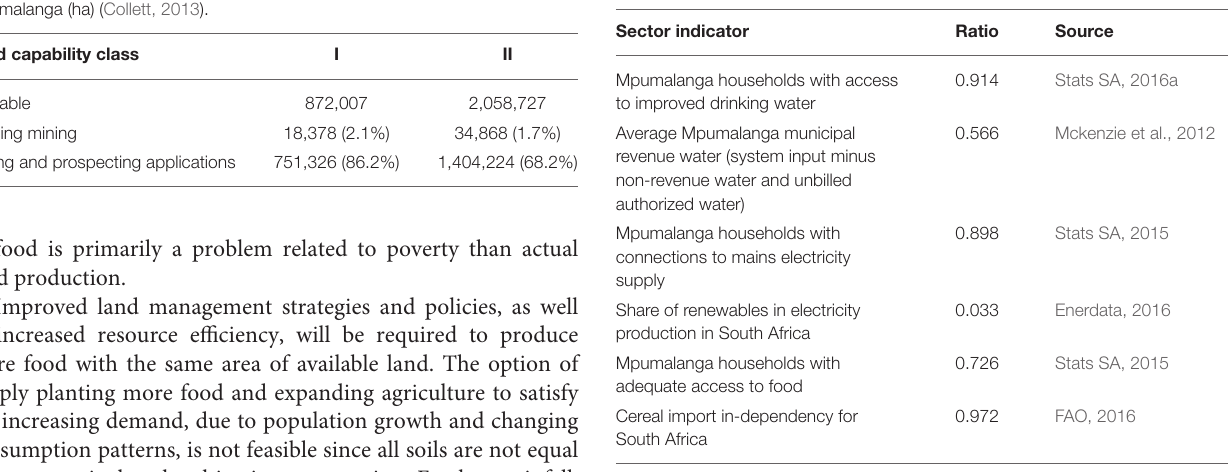
TABLE 3 | Six ratios appertaining to the WEF nexus in the Mpumalanga